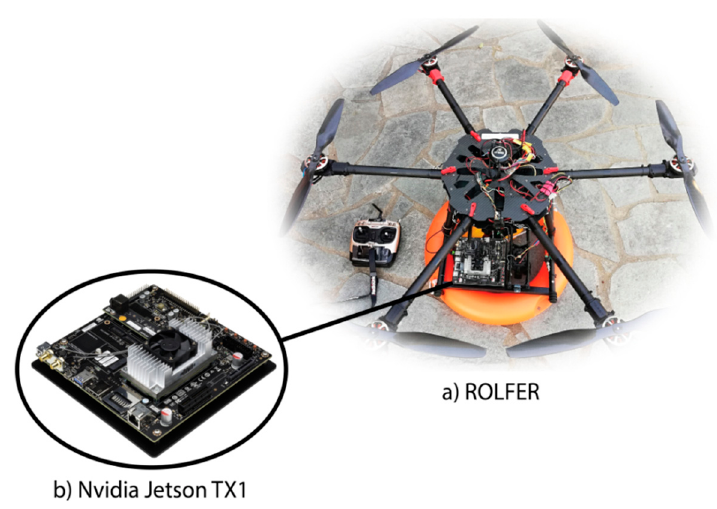
Figure 6. ( a ) The fully autonomous rescue UAV and ( b ) the embedded graphics processing unit (GPU) platform Nvidia Jetson TX1.